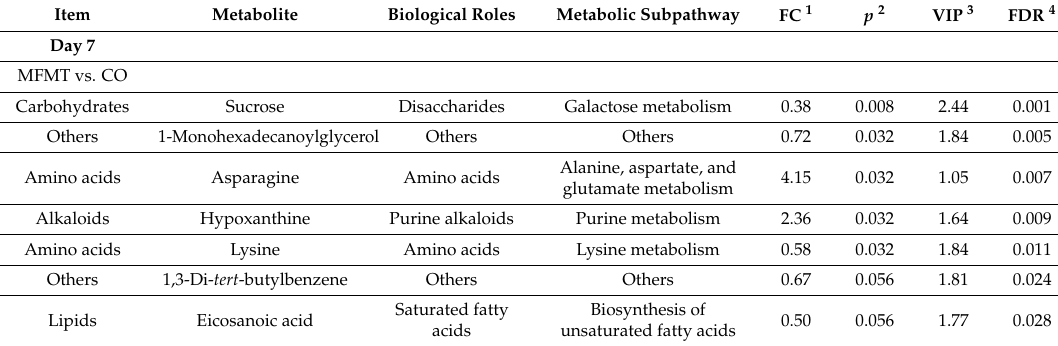
Figure 4. Orthogonal partial least squares discriminant analysis (OPLS–DA) of the microbial metabolites in the colonic contents from pigs in the maternal fecal microbiota transplantation (MFMT), amoxicillin (AM), and control (CO) groups on days 7 ( a ) and 21 ( b ). Table 2. Candidate colon compounds that differed in the maternal fecal microbiota transplantation (MFMT), amoxicillin (AM), and control (CO) groups on days 7 and 21.